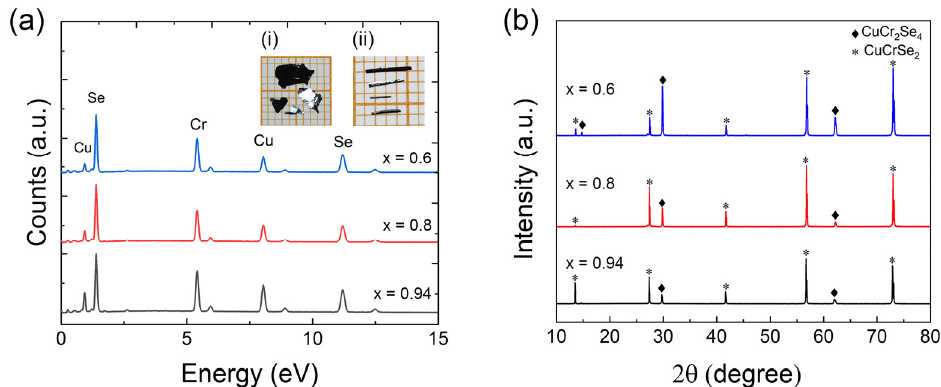
Figure 2. ( a ) The EDS spectra of (CuCr 2 Se 4 ) 1 − x (CuCrSe 2 ) x (x = 0.94, 0.8, 0.6) crystals. The inset of Figure 2a shows the typical photographs of as-grown crystals. ( b ) The X-ray diffraction patterns of as-grown crystals. Stars and lozenges label the XRD reflections from CuCr 2 Se 4 and CuCrSe 2 , respectively.